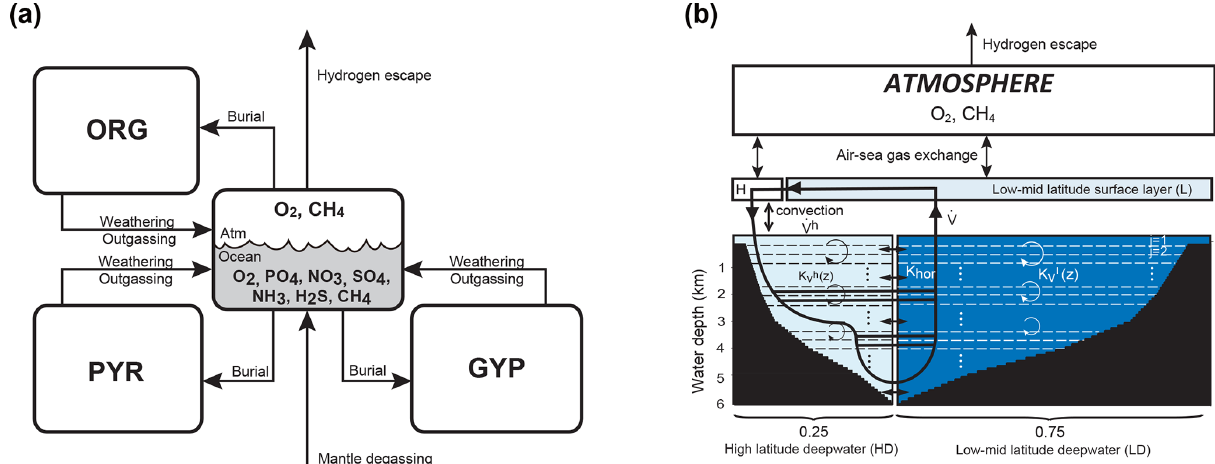
Figure 1. CANOPS-GRB model configuration. (a) The schematic of material cycles in the surface (ocean–atmosphere–crust) system. Three sedimentary reservoirs, organic carbon (ORG), pyrite sulfur (PYR), and gypsum sulfur (GYP), are considered. Sedimentary reservoirs inter- act with the ocean–atmosphere system via weathering, volcanic degassing, and burial. No interaction with the mantle is included, except for the input of reduced gases from the mantle. Total mass of sulfur is conserved in the surface system. (b) Schematic of ocean and atmosphere modules. “L” and “H” denote the low- to mid-latitude mixed surface layer and high-latitude surface layer, respectively. An ocean area of 10% is assumed for H. River flux for each region is proportional to the areal fraction. Ocean interior is divided into two sectors, high-latitude deep water (HD) and low- to mid-latitude deep water (LD), which are vertically resolved. The area of HD is 25% of the whole ocean. The deep overturning circulation, ˙ V , equals the poleward flow in the model surface layer (from L to H). K l v (z) and K h v (z) are the vertical eddy diffusion coefficients in the LD and HD regions, respectively. K hor and ˙ V h are the horizontal diffusion coefficient and polar convection, re- spectively. The black hatch represents the seafloor topography assumed. The parameters regarding geometry and water transport are tabulated in Table